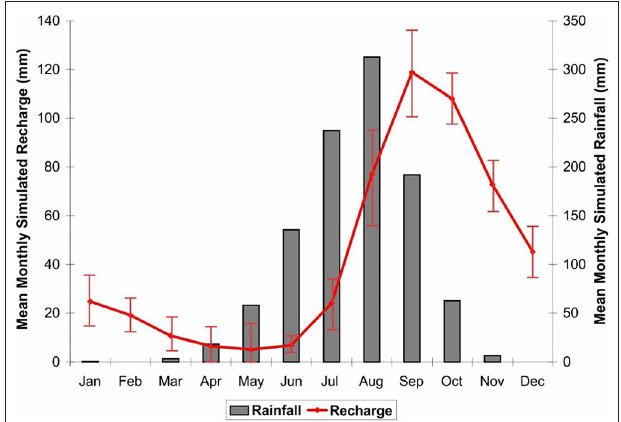
FIGURE 8 | Mean monthly precipitation (right axis) and recharge (left axis) for the average of all four groups at all three depth intervals (12 simulations). Standard deviation shown as